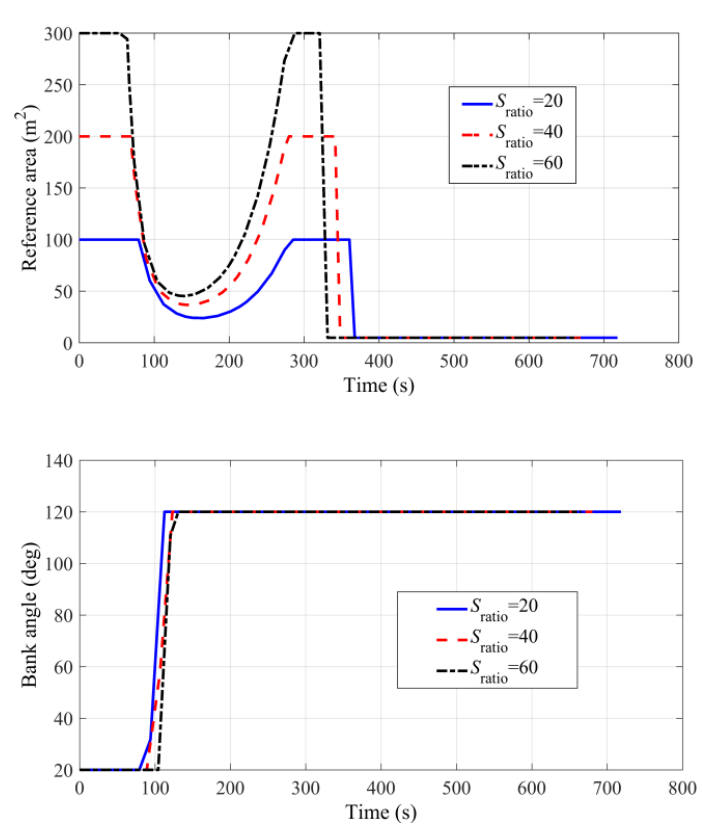
Figure 11. Reference area and bank angle with different reference area ratios.